Question: Generate an informative caption for the figure above.
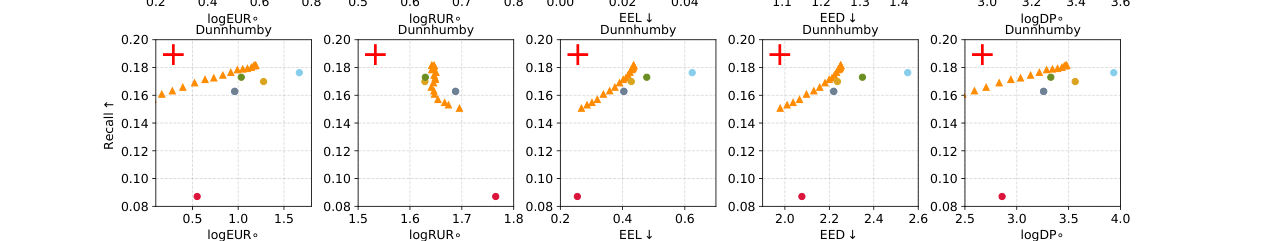
Answer: Performance of TREx𝐹𝑎𝑖𝑟𝑛𝑒𝑠𝑠at different 𝑣values, compared with different NBR methods in terms of different fairness metrics. The red + marker indicates the direction with both high accuracy and fairness.